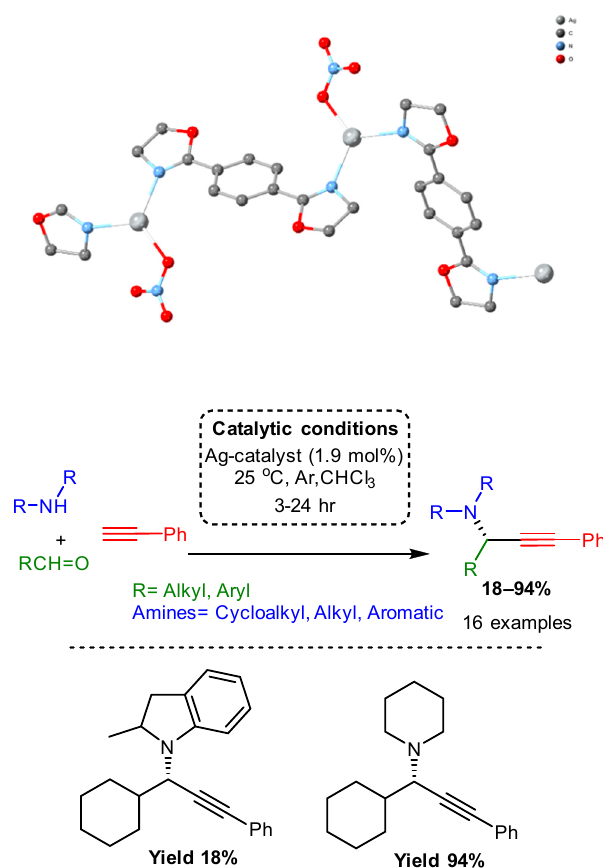
Scheme 56. ( left ) The crystallographically characterised Ag-precatalyst ( right ) scope and limitations of the method.